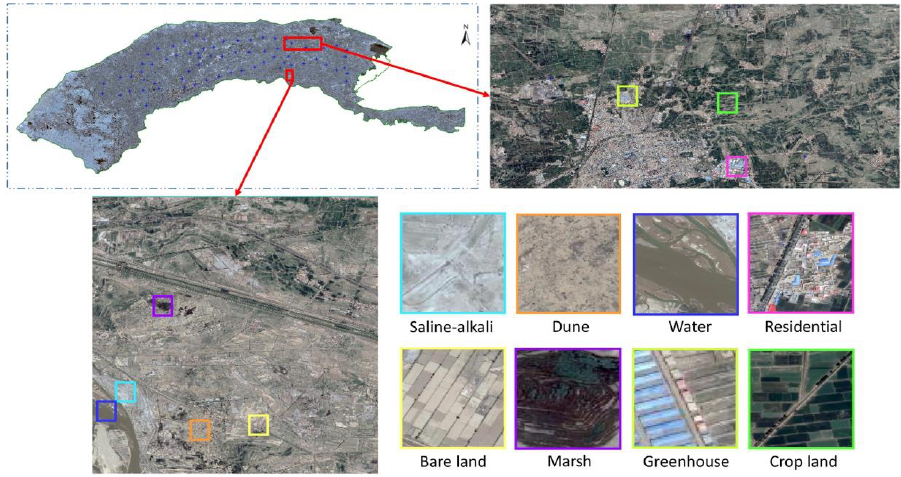
Figure 2. Examples of land use pattern.